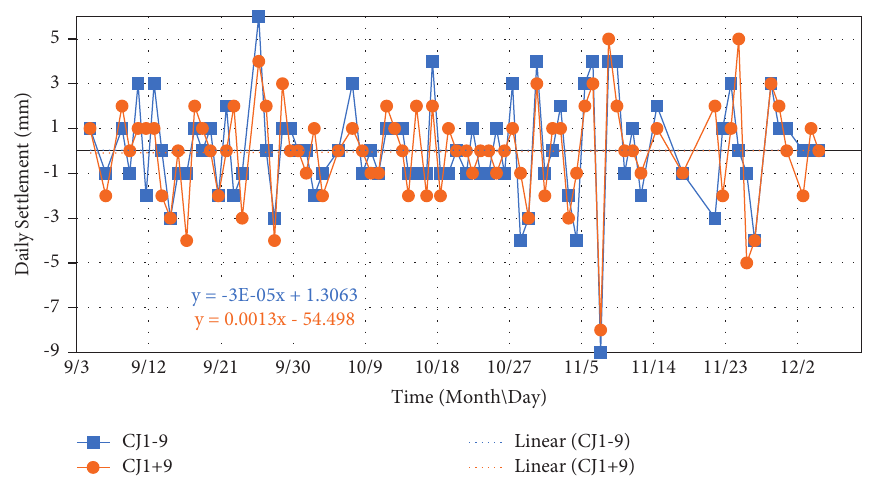
Figure 8: Daily settlement of CJ1-9 and CJ1 +9.